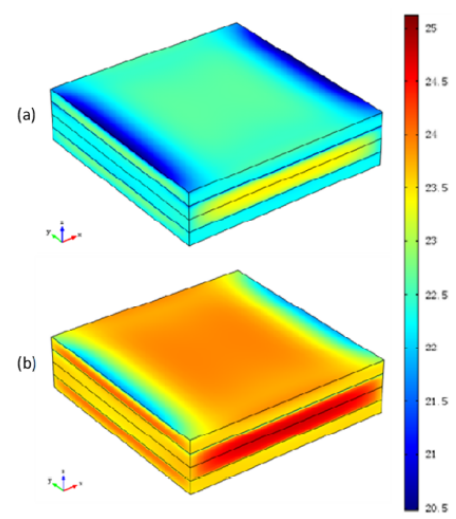
Figure 12. Contours of the von Mises stresses from ( a ) Viscoelastic model, ( b ) Modified CHILE model.